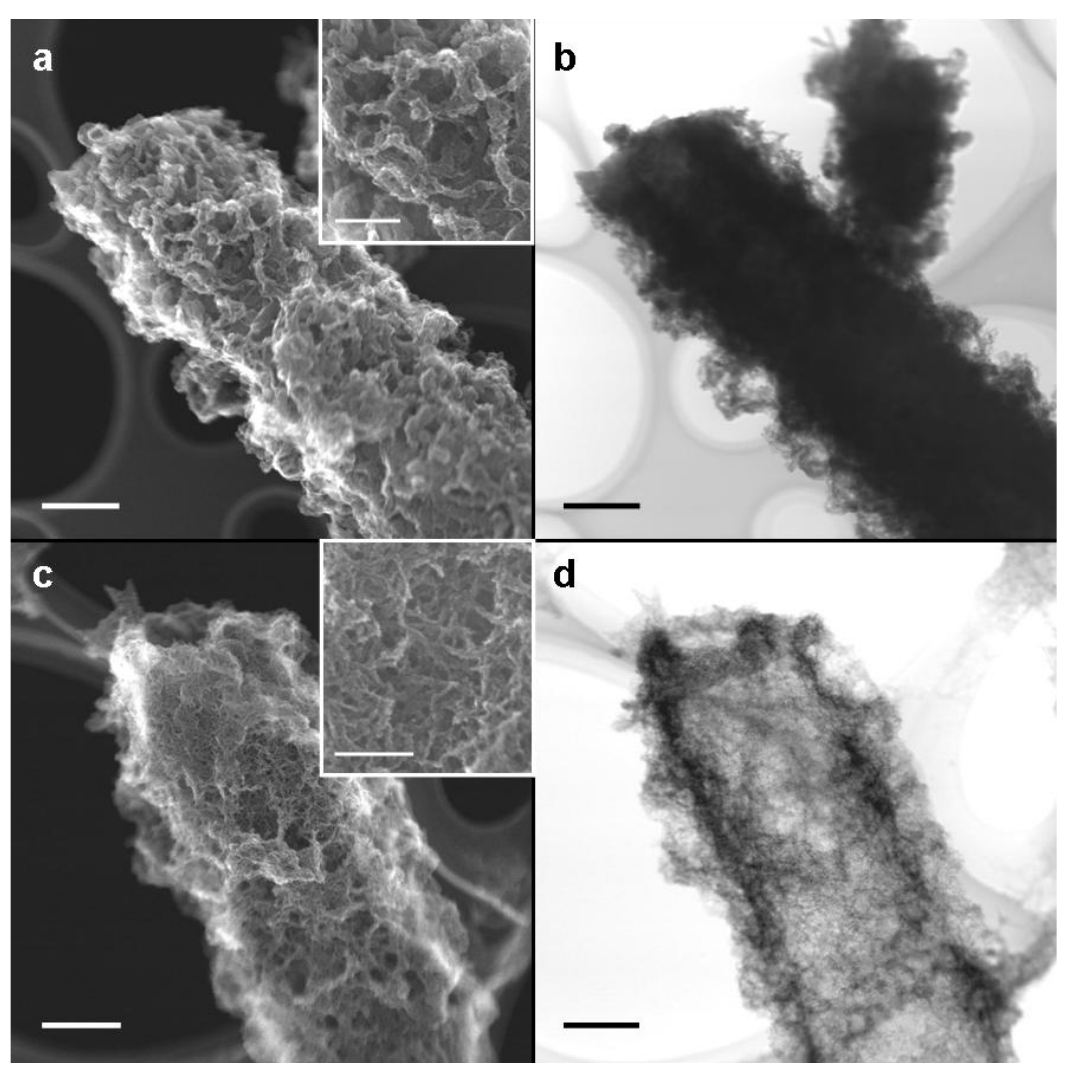
outer sheath. The fibrils are 100–200 nm thick (inset); ( b ) TEM image of (a). The thick inner wall and heavily coagulated outer fibrils blocked transmission of the electron beam, resulting in a dark image; ( c ) STEM-SEI image showing a coagulated fibrous outer sheath. The fibrils are ca. 10 nm thick (inset); ( d ) TEM image of (c) showing a bright image of the entire sheath and fine fibrils in the outer coat. Scale bar = 1 μ m, but 500 nm in c, d, and (a) inset and 100 nm in (c)